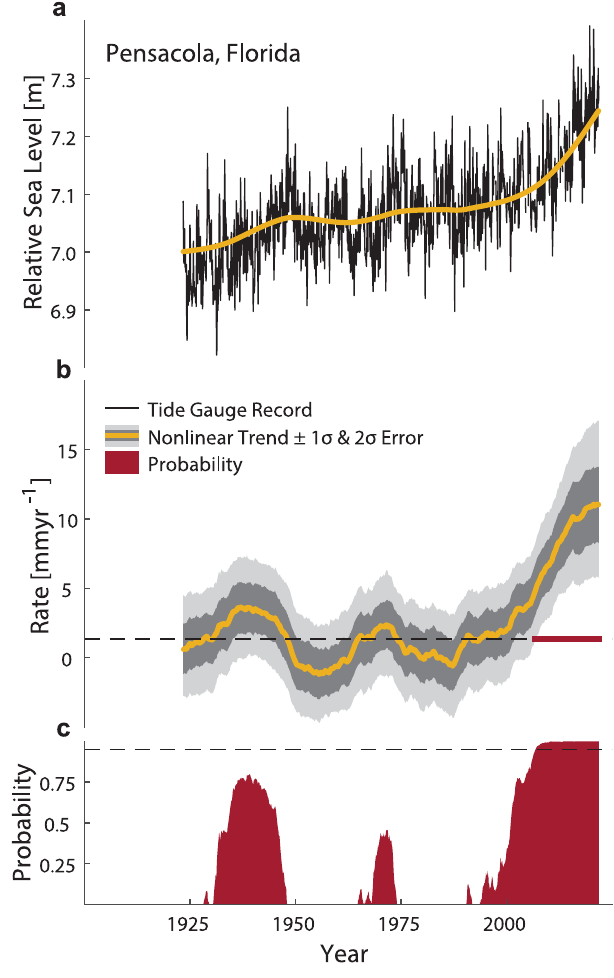
Fig. 1 | Observed relative mean sea level (MSL) rise acceleration at Pensacola, Florida (PSMSL ID 246). a Monthly relative MSL record with its nonlinear trend basedonSingularSpectrumAnalysis(SSA)withacutoffperiodof30years. b Rates of relative MSL rise with the 1- and 2- σ uncertainties from the noise experiment plotted around the observed rates. When the outer bound of the uncertainty envelope exceeds the linear rate (dashed line), the acceleration becomes statisti- cally signi fi cant. The period over which this is the case is marked with a dark red line. c Thecorrespondingprobabilityfunctionfromthenoiseexperimenttogether with the 95% threshold (dashed line) that determines the statistical signi fi cance of an